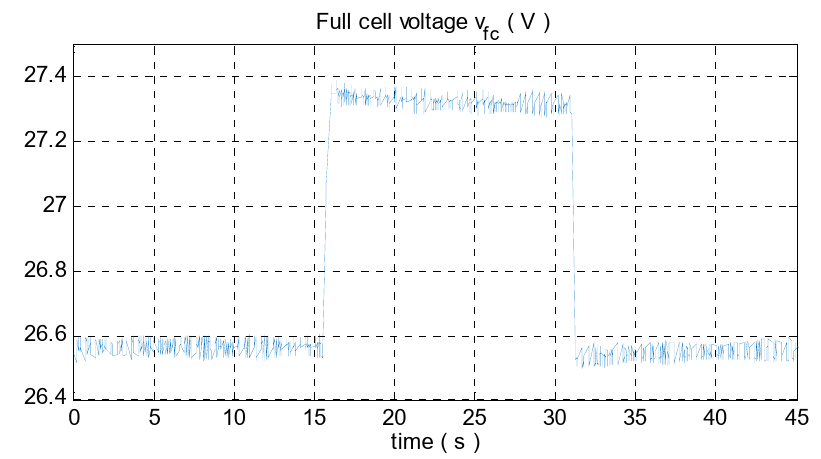
i i = . Figure 29. Inductance current i L = i fc . Electronics 2020 , 9 , x FOR PEER REVIEW L fc i i = . L fc